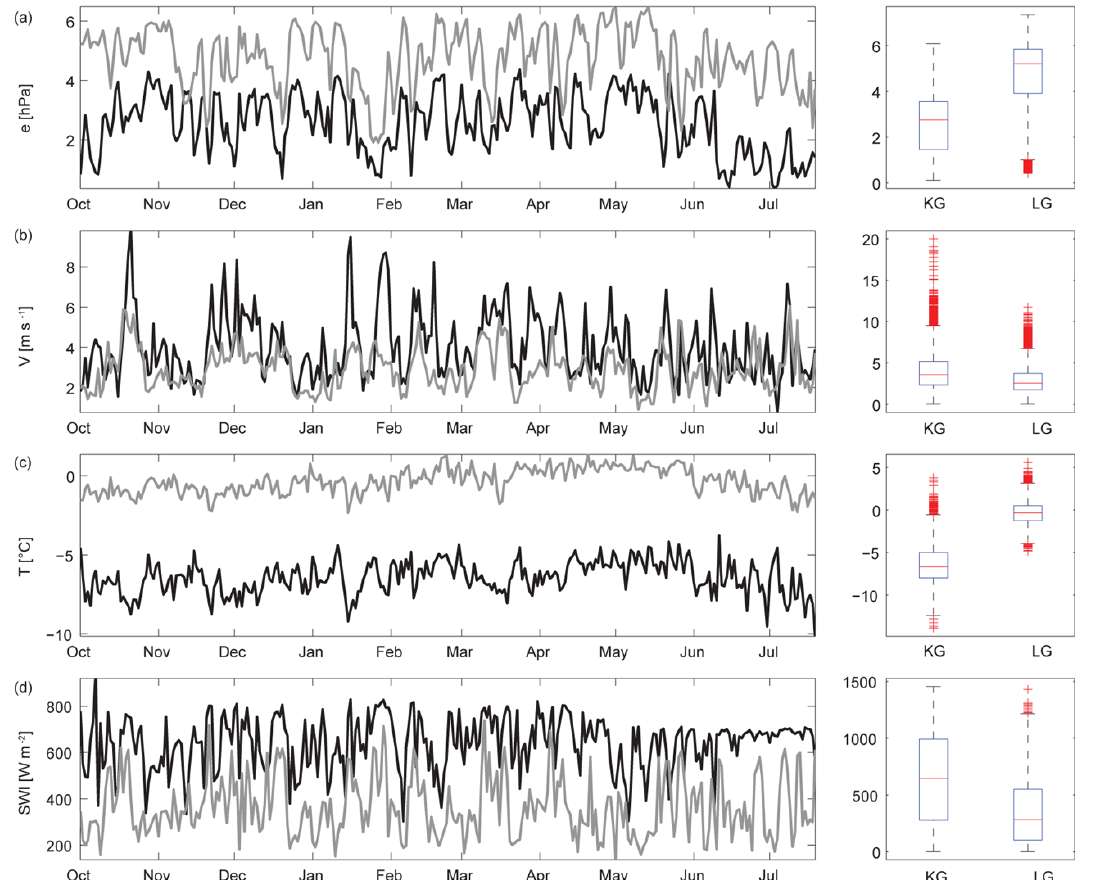
Fig. 7. Comparison of daily mean values of (a) vapor pressure, (b) wind speed, (c) air temperature and (d) incoming shortwave radiation averaged over daylight hours at KG (black line) and LG (gray line). Box plots to the right show the median, interquartile range and outliers of each meteorological variable measured at LG and LG AWS over the period of common measurement (1 October 2009–19 July